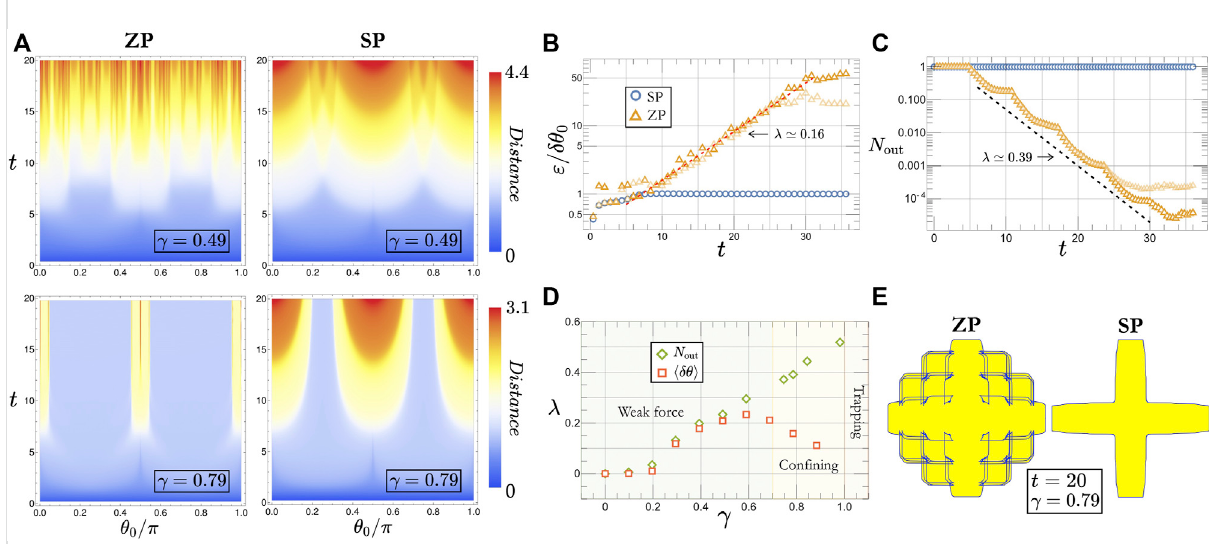
FIGURE 3 Sensitivity of the navigation policies to the initial orientation. (A) Color maps of the distance from the starting point as a function of the initial angle θ 0 andtime t forbothZP(leftcolumn)andSP(rightcolumn)intwodifferentregimes:weakforce( γ =0.49,toprow)andcon fi ningpotential( γ = 0.79, bottom row). (B) Scaling with a time of the mean angular separation ε de fi ned in Eq. 4 for SP (blue circles) and ZP (orange triangles) at γ = 0.79. Opaque and semi-transparent symbols, respectively, correspond to an initial orientation resolution of δθ 0 = 10 − 6 and δθ 0 = 10 − 5 . (C) Number of trajectories located on the outer isochrone as a function of time; the legend and parameters are the same as those in (B) . (D) Best fi ts of the two sets of exponents obtained from the exponential scalings of ε and N out [see (B) and (C) ]for ZP as a function of γ . (E) Example of long-time isochrones ( t = 20) in the con fi ning regime ( γ = 0.79) for the two policies. In both cases, the blue curve represents the entire isochrone, while the area highlighted in yellow is the region enclosed by the outer boundary. The complexity of the ZP isochrone is consistent with its larger sensitivity to the initial self- propulsion